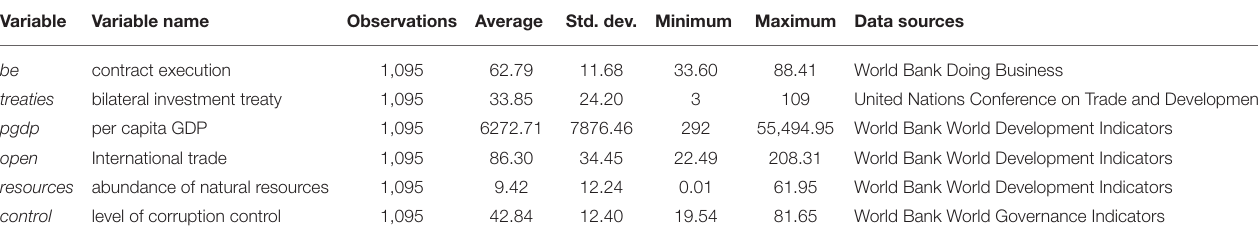
TABLE 1 | Descriptive